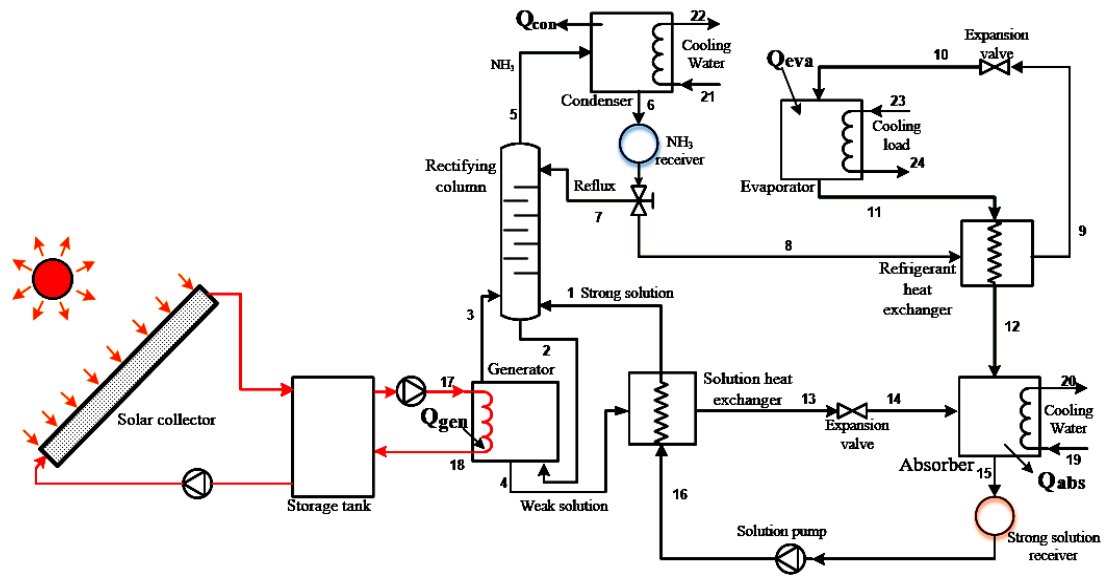
Figure 1. Single-stage NH 3 /H 2 O solar absorption refrigeration system.